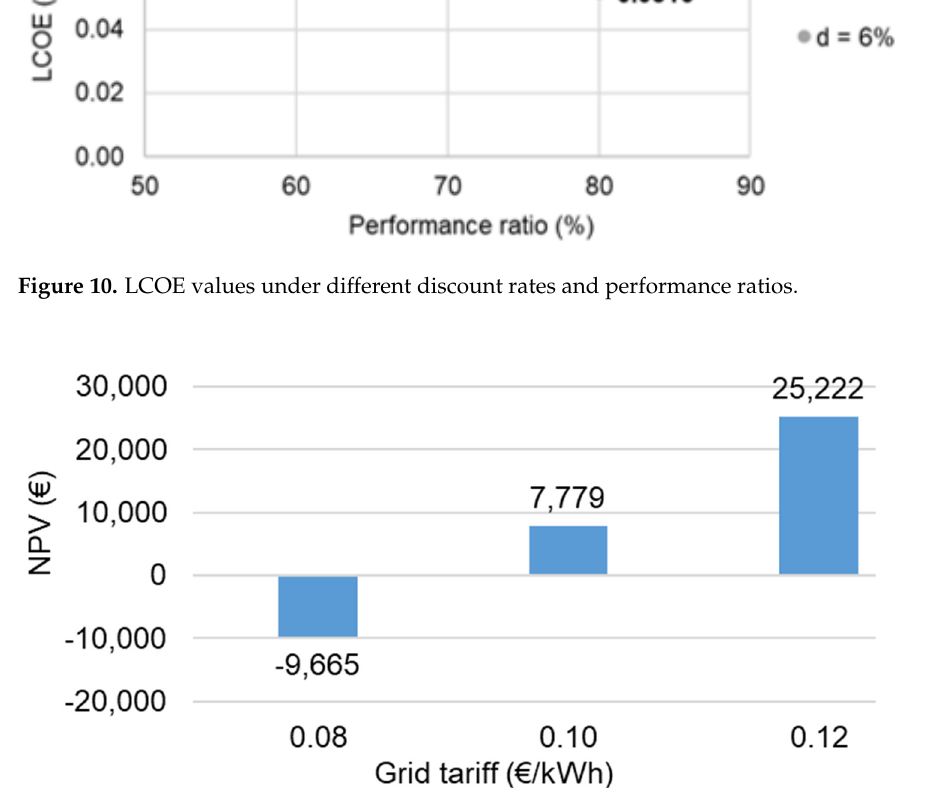
Figure 11. Effect of the electricity selling price to NPV, a case for investors.